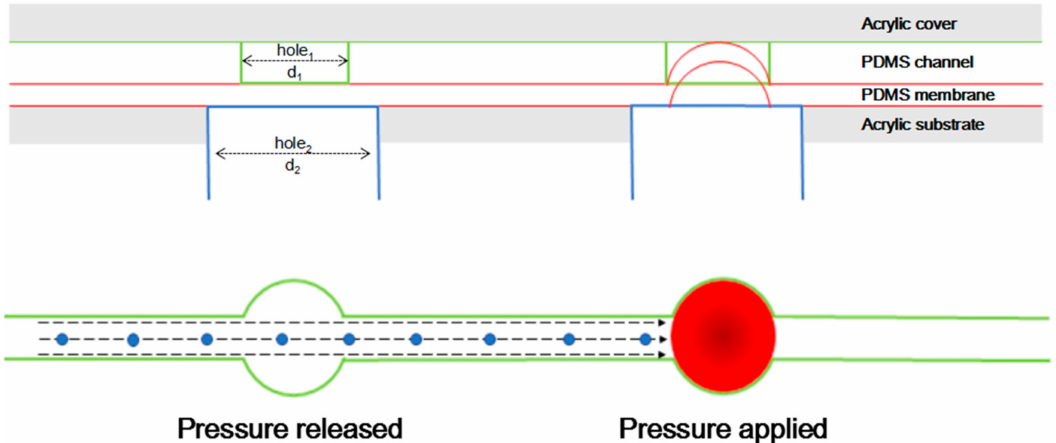
Figure 2. The schematic design of the cross section of the microfluidic device. This device consisted of 4 layers.